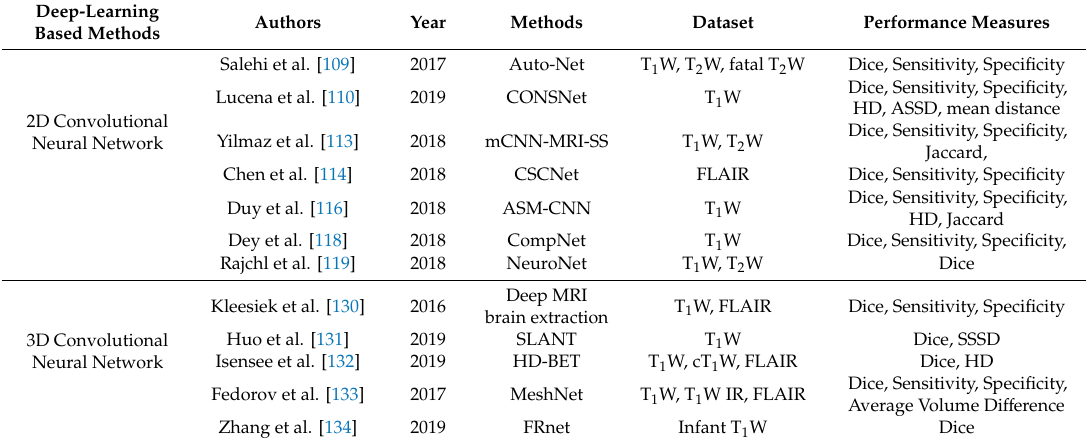
Table 4. Notable algorithms of deep learning-based